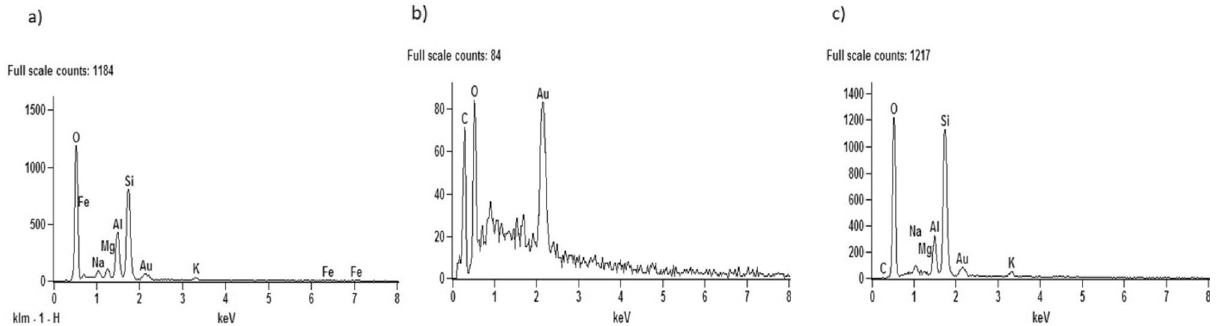
Figure 5. EDS analysis of the materials studied: ( a ) MMt, ( b ) GO, and ( c ) GO–MMt.